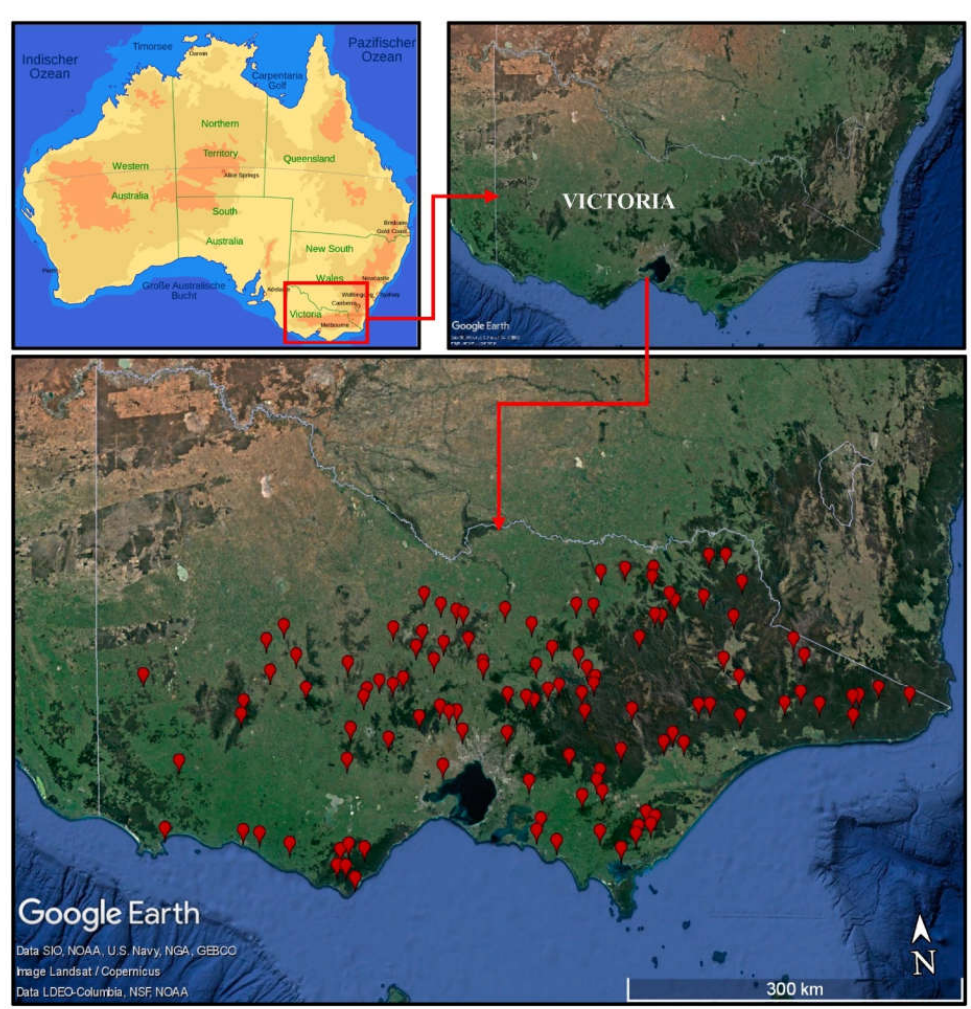
Figure 1. Location of study catchments in Victoria, Australia. Table 1. Summary of catchment characteristics data.